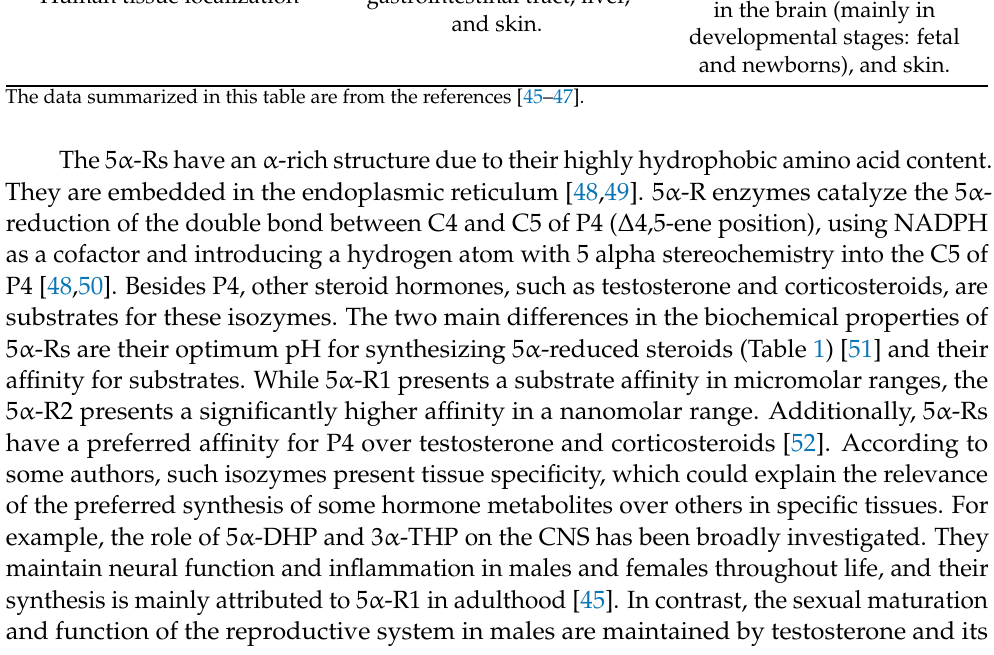
Table 1. Comparative characteristics of the 5 α -R isozymes involved in the 5 α -reduction of steroids. Isozyme: 5 α -R1 5 α -R2 Gen/localization SRD5A1/5p15.31 SRD5A2/2p23.1 Exons number 7 9 Protein weight 29.4 kDa 28.4 kDa Optimum pH 6–8.5 ~5 Almost exclusive in the male reproductive system, liver, Brain (mainly in adulthood), and lungs. It is also reported Human tissue localization gastrointestinal tract, liver, in the brain (mainly in and skin. developmental stages: fetal and newborns), and